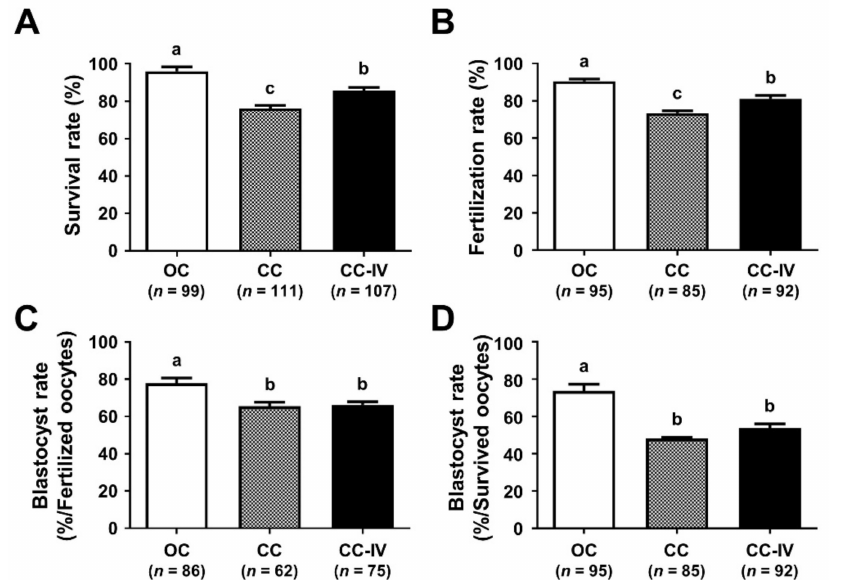
Figure 4. The effects of expanding the volume of the first warming solution to increase the warming rate on the survival and development rates of vitrified/warmed (VW) oocytes. Comparison of the survival ( A ), fertilization ( B ), and blastocyst formation rates ( C , D ) of VW oocytes exposed to enlarged volume of first warming solution. Blastocyst formation rates (the number of blastocysts/the number of fertilized embryos ( C ) and/the number of survived oocytes ( D )). Different superscript letters (a–c) indicate p < 0.05. The number of experiments = 4 (20–25 oocytes per group in each experiment). OC, open carrier system; CC, closed carrier system with standard volume (1 mL); CC-IV, closed carrier system with an increase in the volume of first warming solution (3.5